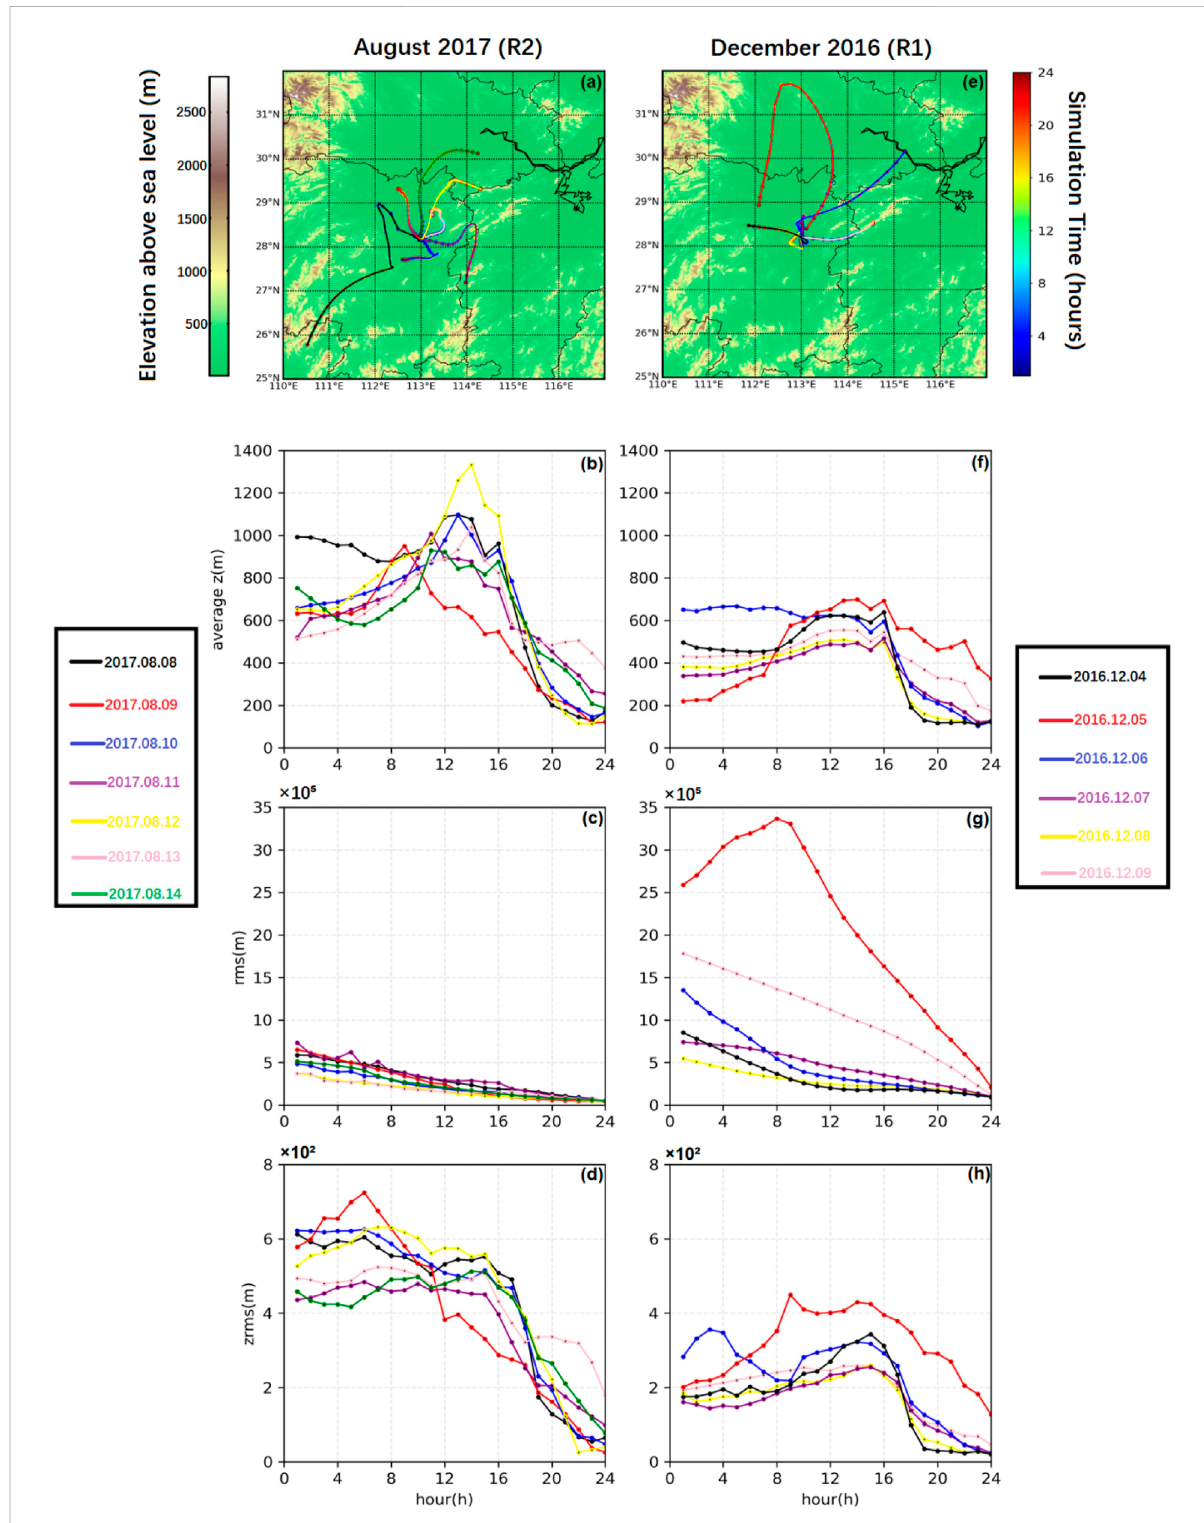
FIGURE 14 Simulation of R1 and R2 process, (A) the particle center of mass movement trajectory during R2, (B) the height variation curve of the particle mass center during R2, (C) the horizontal dispersion variation curve (rms) during R2, (D) the vertical dispersion variation curve of the particle swarm (zrms) during R2, (E – H) the same as (A – D) but for R1